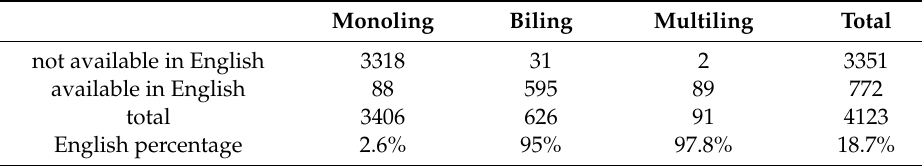
Table A30. English language availability